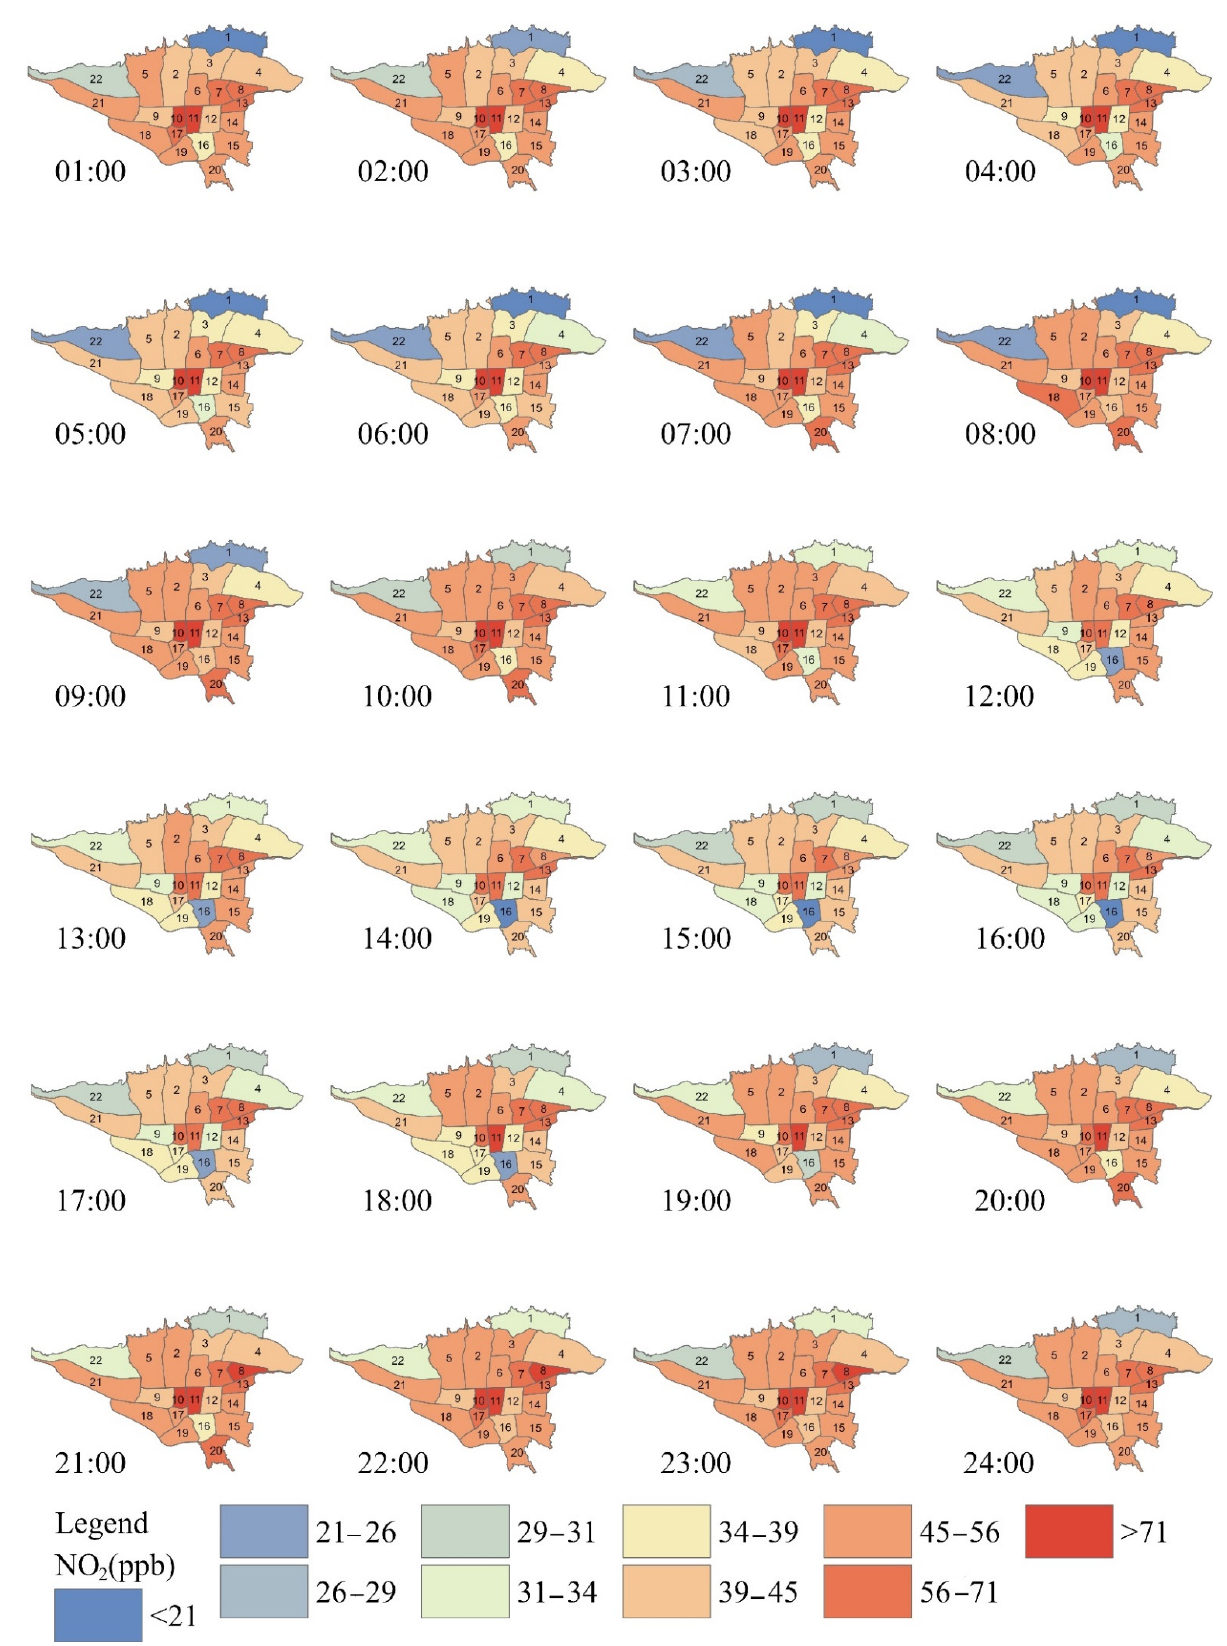
Figure 7. The predicted maps of the NO 2 concentrations for the hours from 1:00 to 24:00 in all districts of